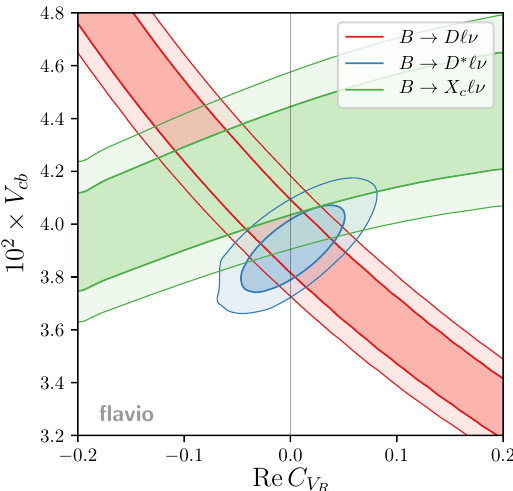
Figure 2 . Constraints on right-handed currents from inclusive and exclusive decays, assuming